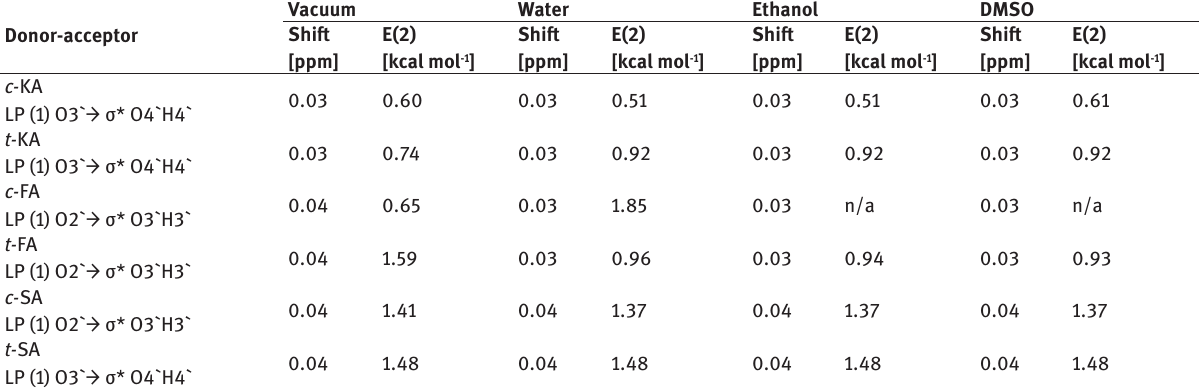
Table 3: Analysis of the interaction between electron donor and acceptor orbitals calculated with B3LYP/6-311++G(2d,2p) level of theory.